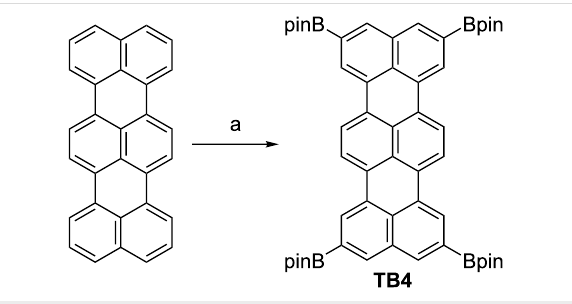
TB4 in toluene absorbs UV–vis light with an absorption maximum at 566 nm, and emits fluorescence at 576 nm with a quantum yield of Φ F = 0.86 at 298 K (Figure 3). Both peaks are slightly red-shifted relative to those of intact terrylene ( λ abs = 560 nm and λ em = 571 nm with Φ F = 0.82 in